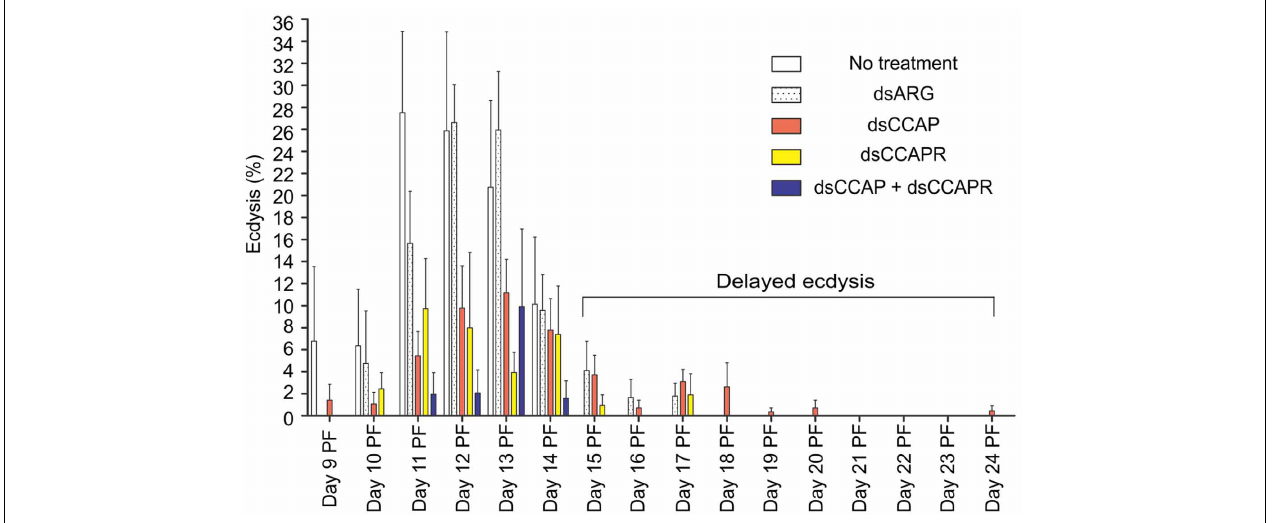
FIGURE 7 | Some 4th instar R. prolixus that had knockdown of RhoprCCAP , RhoprCCAPR or both did not die and were still able to ecdyse; however, many of them had delayed ecdysis. Insects injected with dsCCAP, dsCCAPR, or dsCCAP and dsCCAPR displayed an